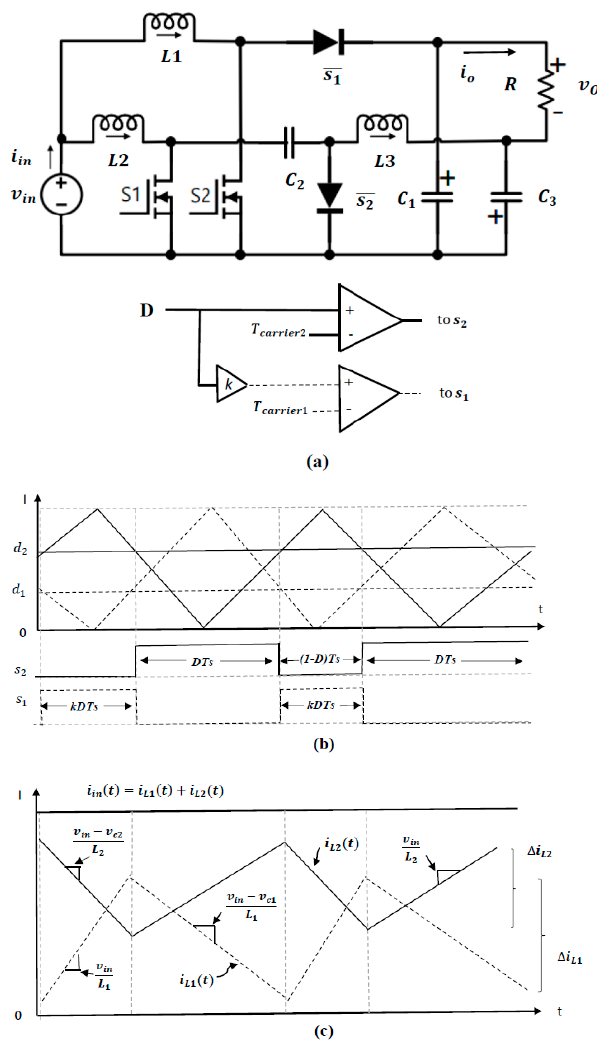
Figure 1. Hybrid power converter proposed in [31]. ( a ) Structure, ( b ) PWM strategy, and ( c ) Wave- forms of the input current ripple.